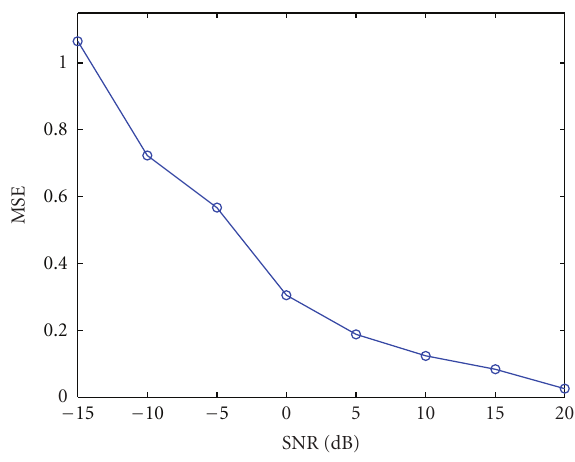
Figure 5: MSE under di ff erent noise levels.